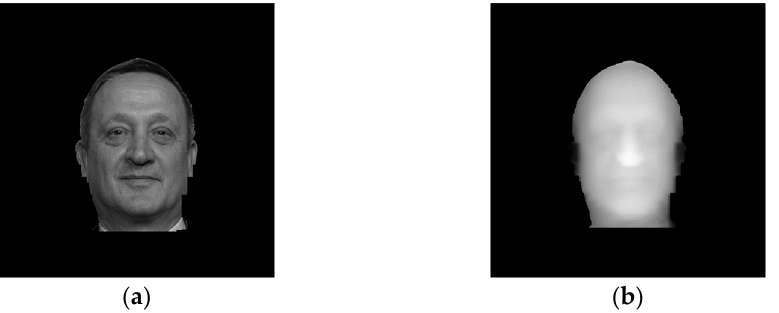
Figure 2. Initial frames of digital processing: ( a ) RGB image of the scene to be holographed (texture); ( b ) the image of the scene to be holographed, with the projection of structured fringes superposed on the holographic object; ( c ) the selected fringe array; ( d ) transformation of the horizontal shift to deep grey (depth map); and ( e ) virtual 3D model of the holographic object.